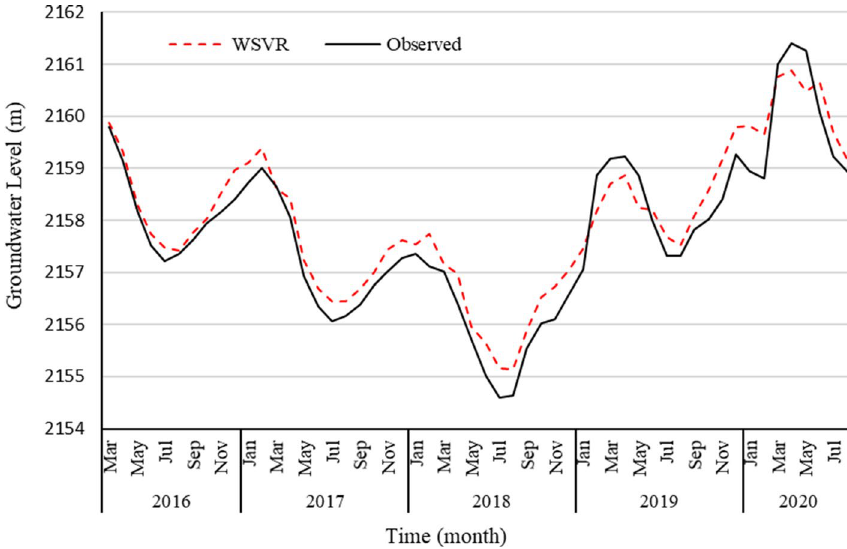
Fig. 10 Comparison of the W-SVR model with observed data